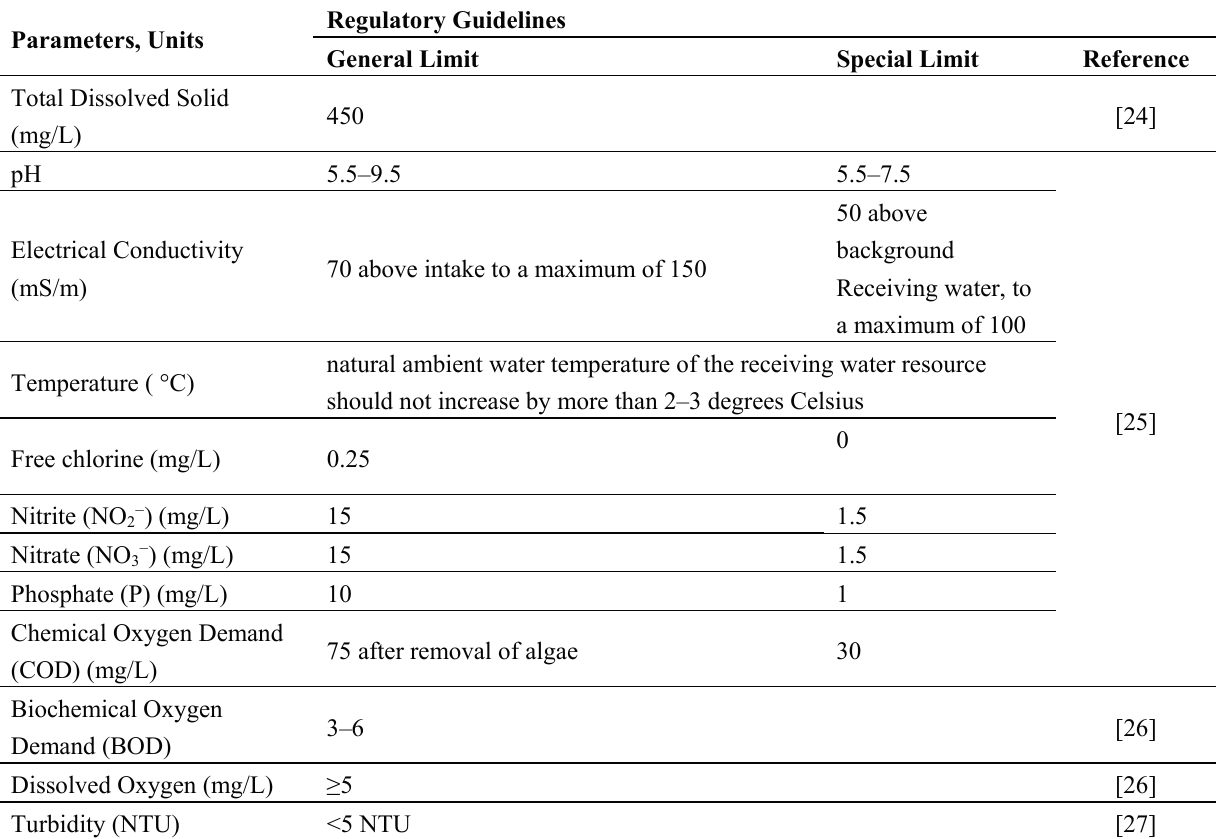
Table 1. List of recommended parameters and